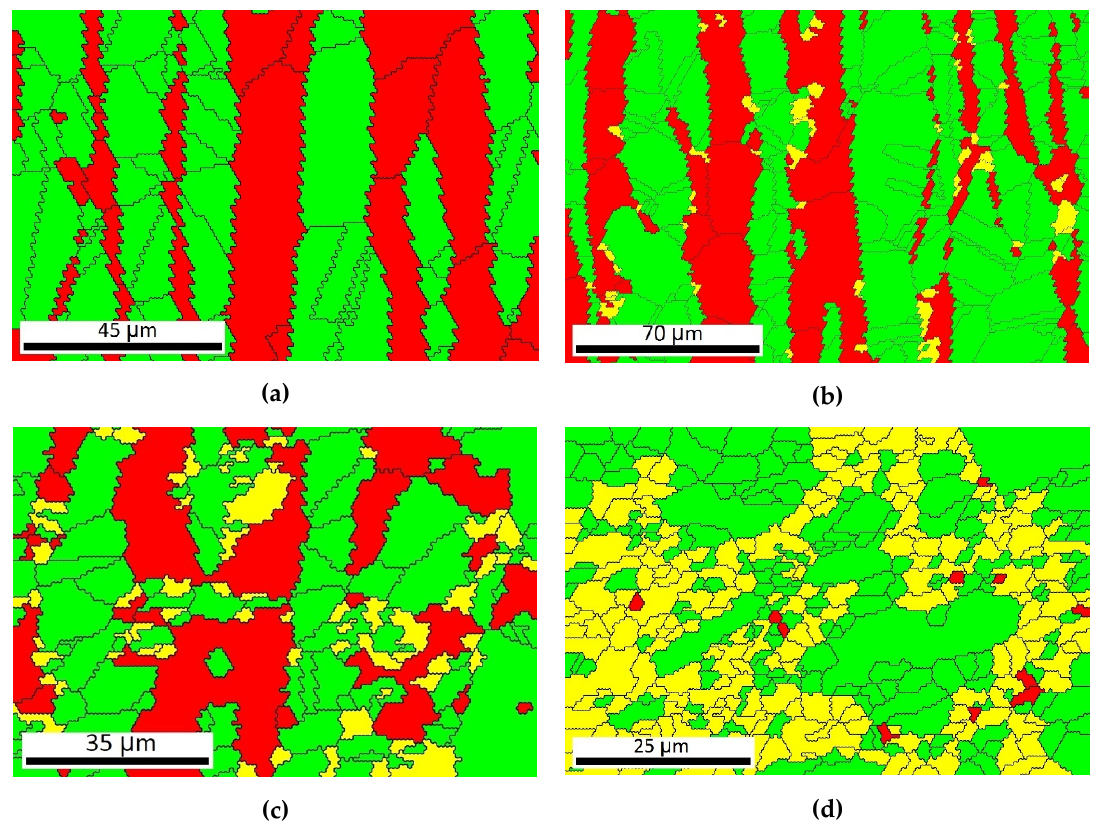
Figure 10. Phase maps made by EBSD: ( a ) The original phase ration of the 2507-type SDSS; ( b ) heat-treated sample at 850 ◦ C without deformation; ( c ) ε = 22.3% deformed sample and heat treated at 850 ◦ C; ( d ) ε = 61.9% deformed sample and heat treated at 850 ◦ C. (Color marking: red area— δ -ferrite; green area—austenite; yellow area— σ -phase)